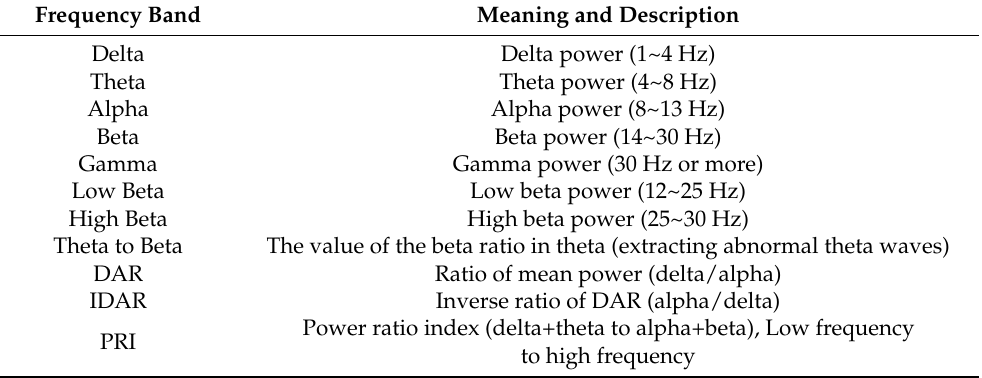
Table 1. Detailed descriptions of newly defined and extracted EEG